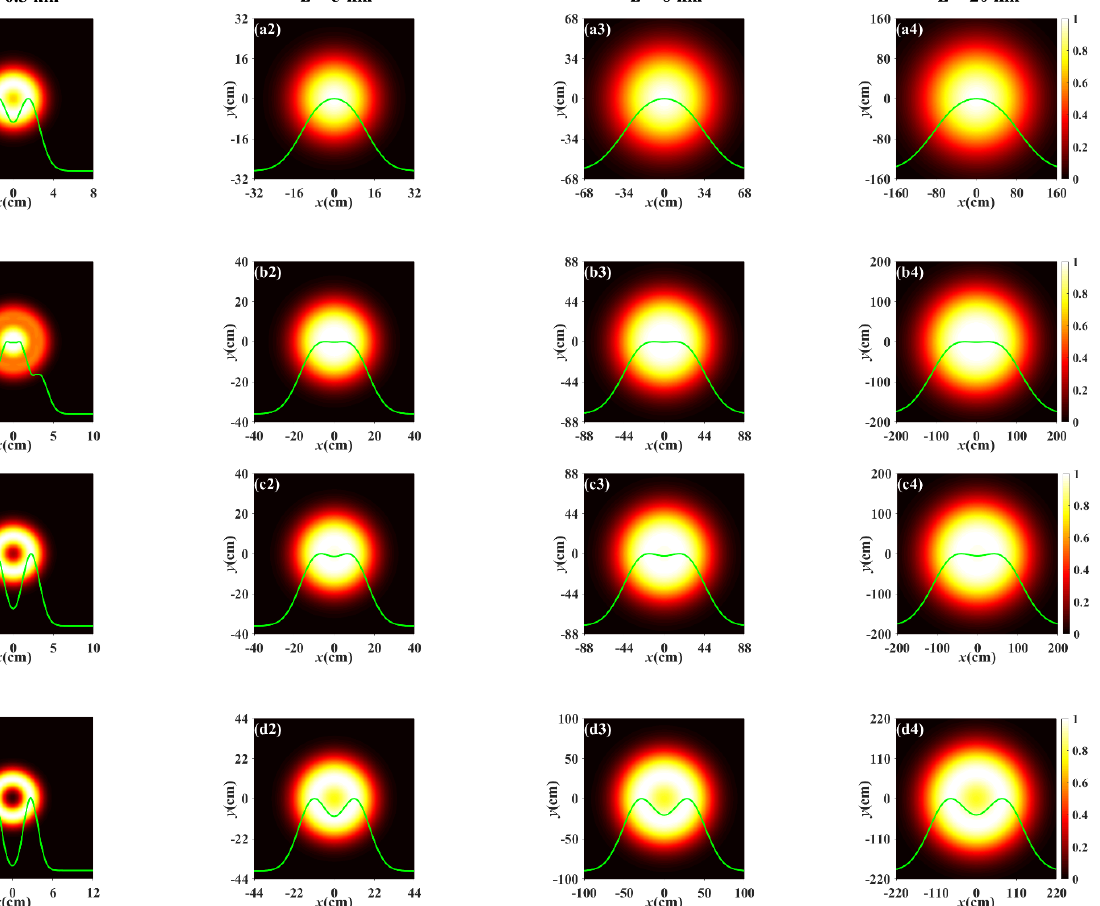
Figure 2. Normalized spectral intensity distribution of the PCTLGP beam at several propagation distances in anisotropic turbulence for different mode orders and topological charges ( ξ x = ξ y = 3, C ̃ 2